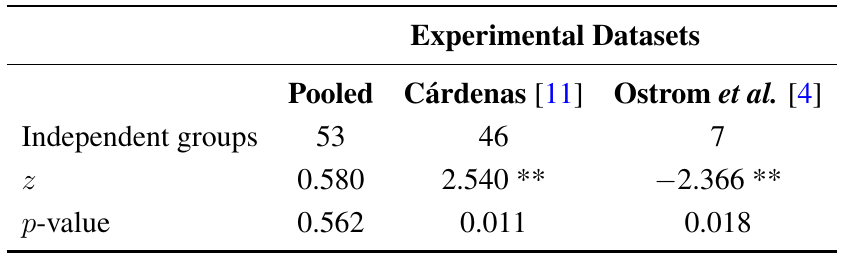
Table 5. Wilcoxon signed rank